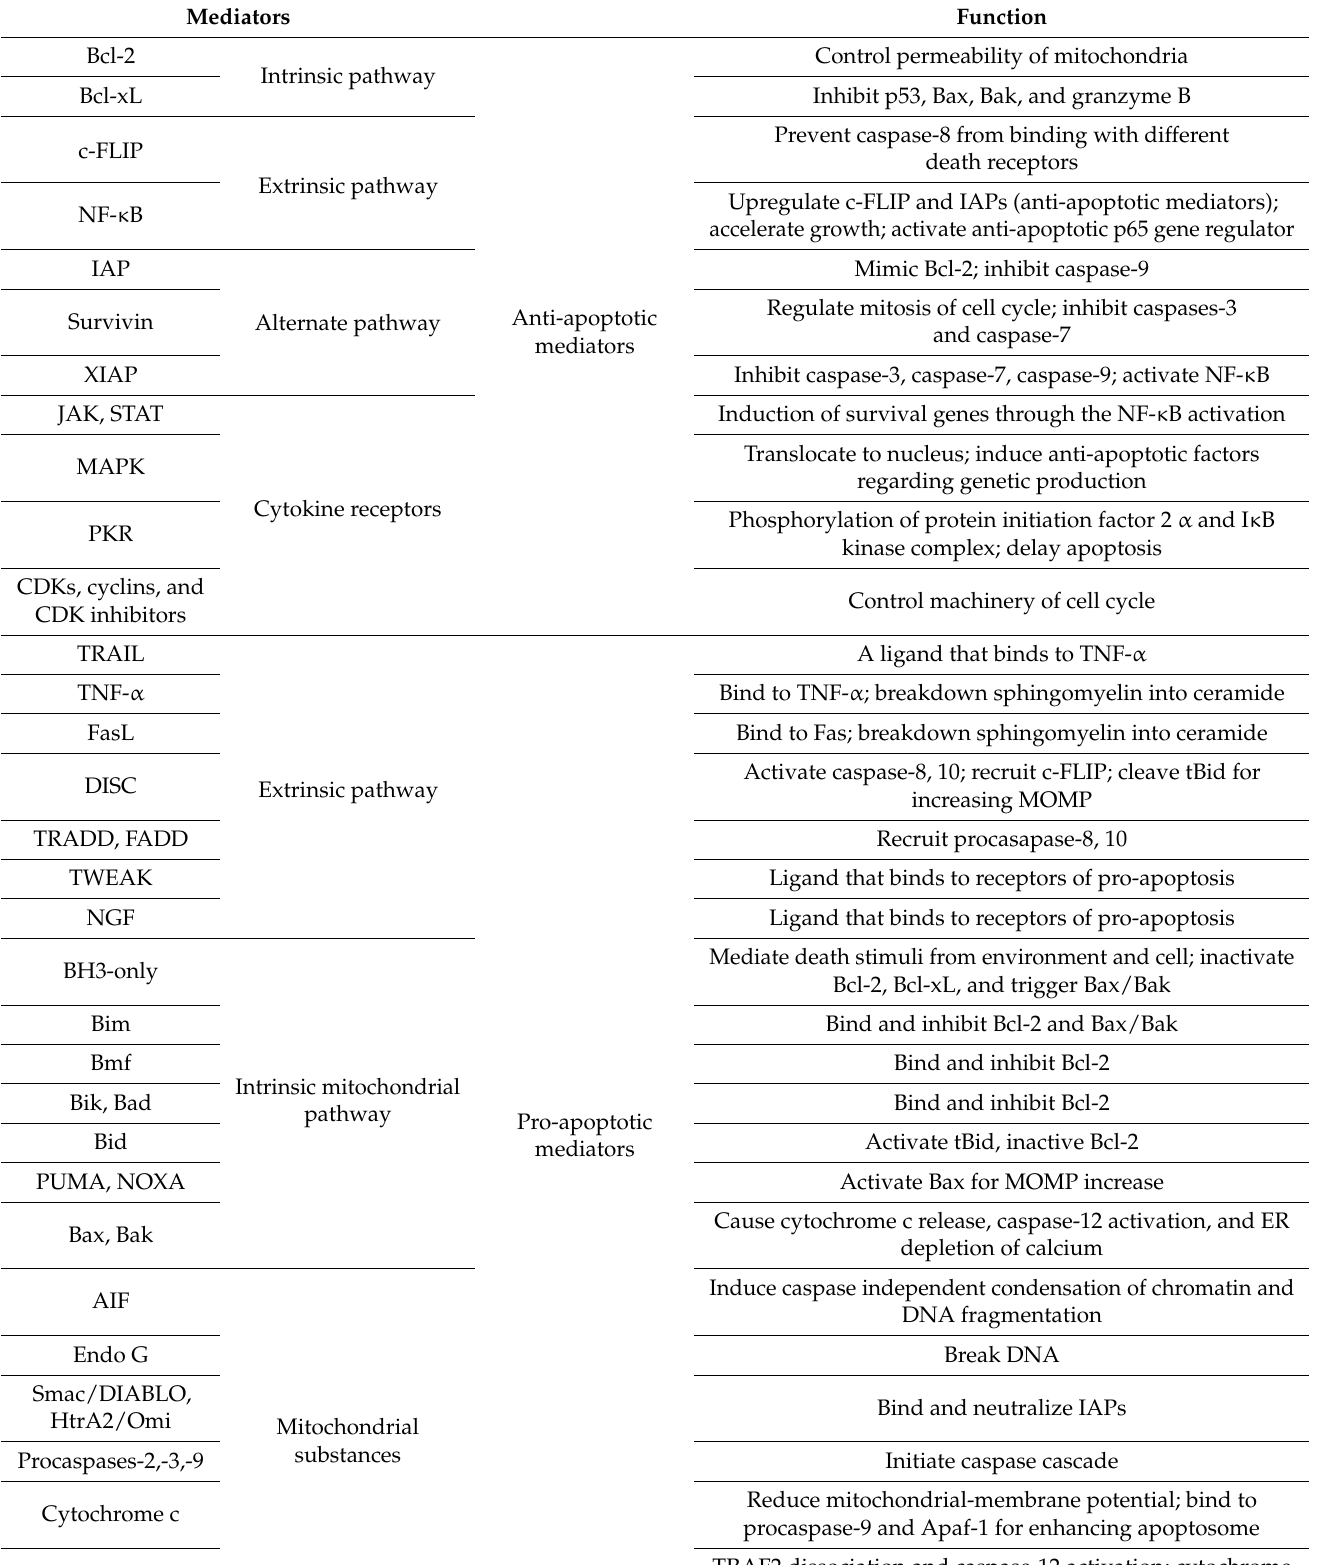
Table 1. The various mediators of apoptosis and their functions